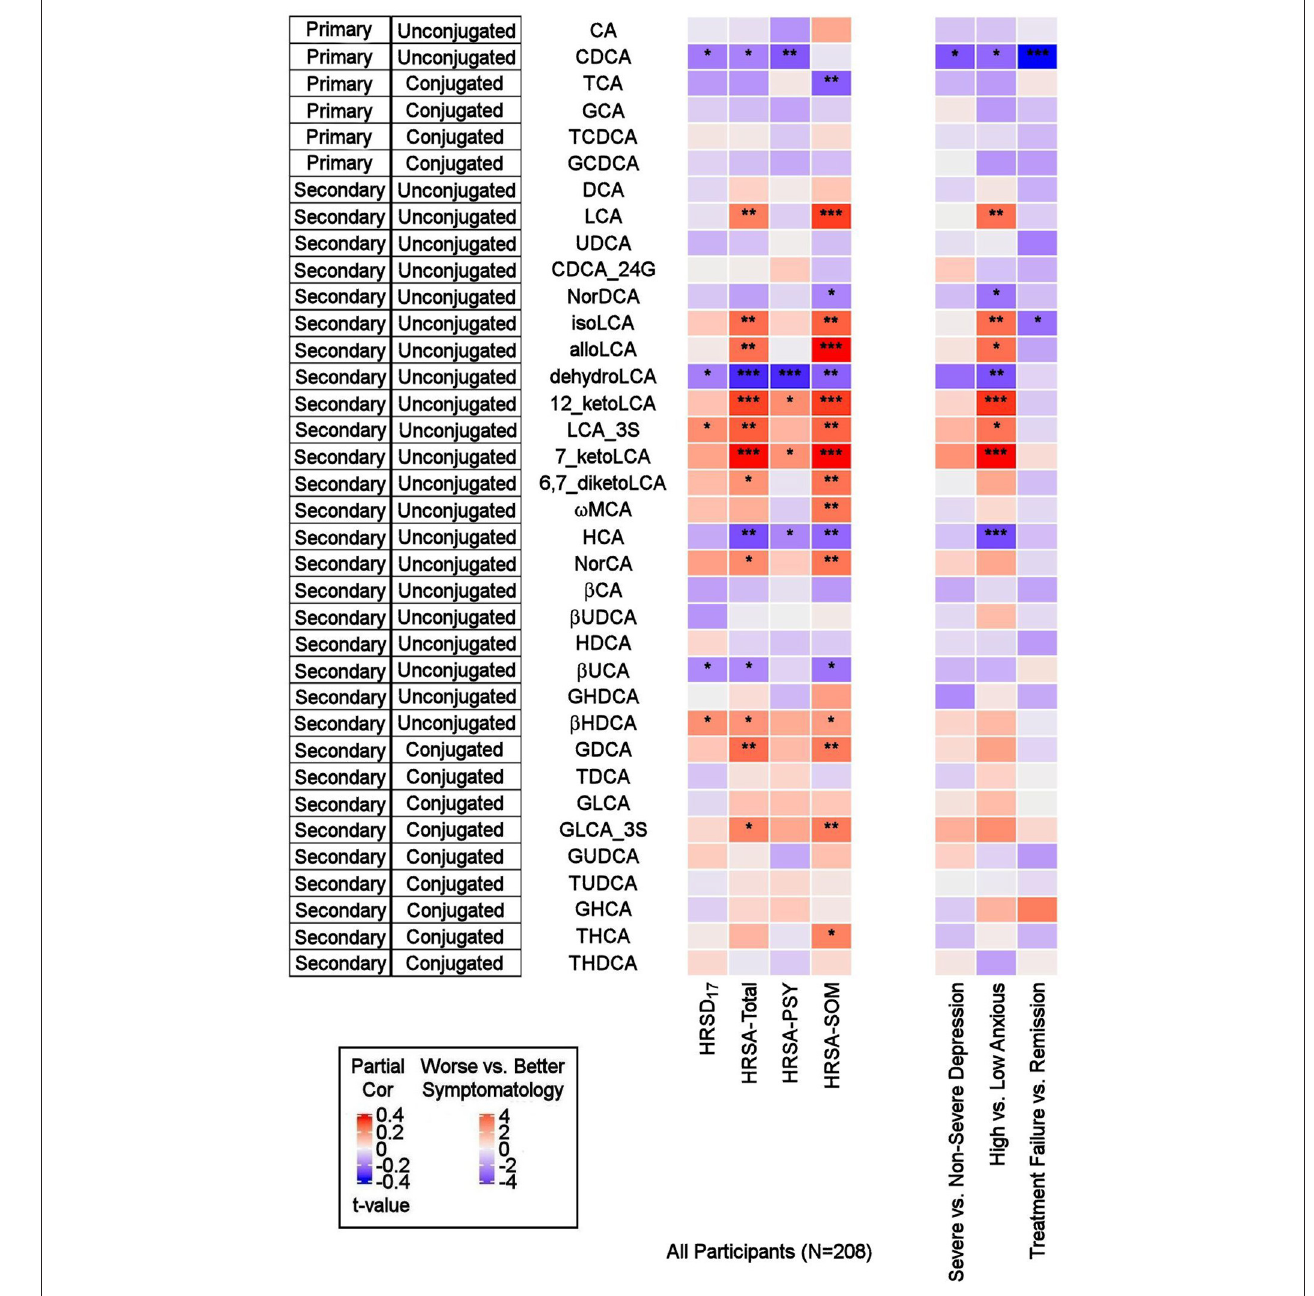
FIGURE 2 | Correlations between baseline BAs and depression and anxiety scores, and differences in baseline BA profiles between several participant groups. On the left: Heat map of partial Spearman rank correlations between baseline BAs and scores on the HRSD 17 and Hamilton Anxiety Rating Scale and subscales, after accounting for age, sex, and body mass index. On the right: Heat map of differences in baseline BA profiles in severe vs. non-severe depressed, high vs. low anxiety and treatment-failure vs. remitter groups. T -values were used for visualization purposes and the Wilcoxon Ranked Sum Test were used to test the significance of differences. BA, Bile Acid; CA, Cholic Acid; CDCA, Chenodeoxycholic Acid; DCA, Deoxycholic Acid; GCA, Glycocholic Acid; GCDCA, Glycochenodeoxycholic Acid; GDCA, Glycodeoxycholic Acid; GHCA, Glycohyocholic Acid; GHDCA, Glycohyodeoxycholic Acid; GLCA, Glycolithocholic Acid; GUDCA, Glycoursodeoxycholic Acid; HCA, Hydroxycitric Acid; HDCA, Hyodeoxycholic Acid; HRSA-PSY, Psychic anxiety subscore of the Hamilton Anxiety Rating Scale; HRSA-SOM, Somatic anxiety subscore of the Hamilton Anxiety Rating Scale; HRSA-Total, 14-item Hamilton Anxiety Rating Scale; HRSD 17 , 17-item Hamilton Depression Rating Scale; LCA, Lithocholic Acid; MCA, Monocarboxylic Acid; TCA, Taurocholic Acid; TCDCA, Taurochenodeoxycholic Acid; TDCA, Taurodeoxycholic Acid; THCA, Tetrahydrocannabinolic Acid; THDCA, Taurohyodeoxycholic Acid; TUDCA, Tauroursodeoxycholic Acid; UCA, Ursocholic Acid; UDCA, Ursodeoxycholic Acid; _3S, 3 Sulfate. *uncorrected p -value < 0.05. **uncorrected p -value < 0.01. ***uncorrected p -value < 0.001.